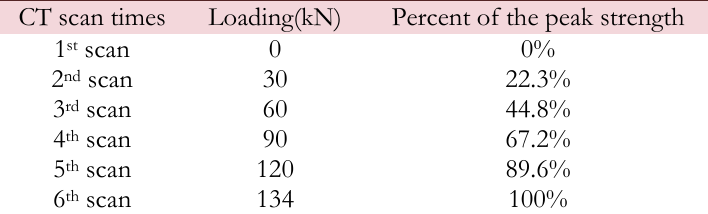
Table 2: The load corresponding to the six scanning time of the concrete specimen.